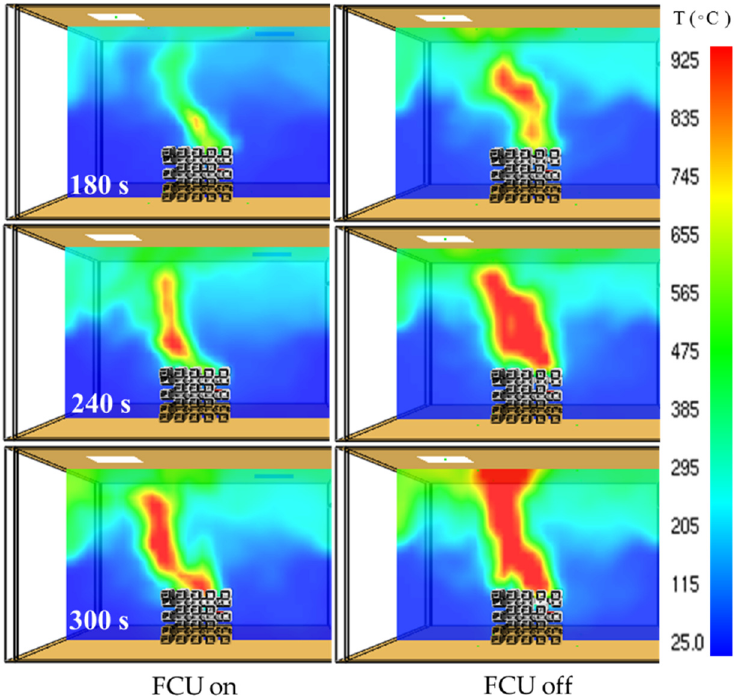
Figure 8. Temperature distribution slices of smoke layer at 180 s, 240 s and 300 s for the two modes in the square room.